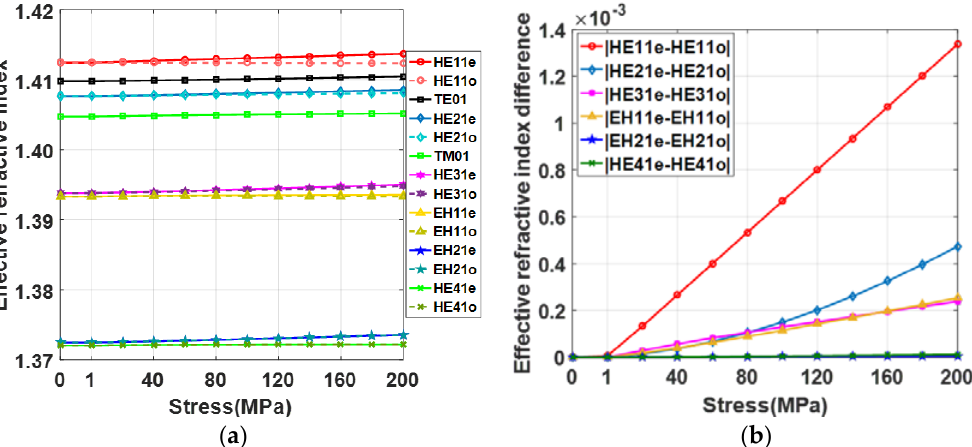
Figure 3 . ( a ) Effective refractive index as a function of stress for different modes; ( b ) effective index difference between even and odd modes as a function of stress.